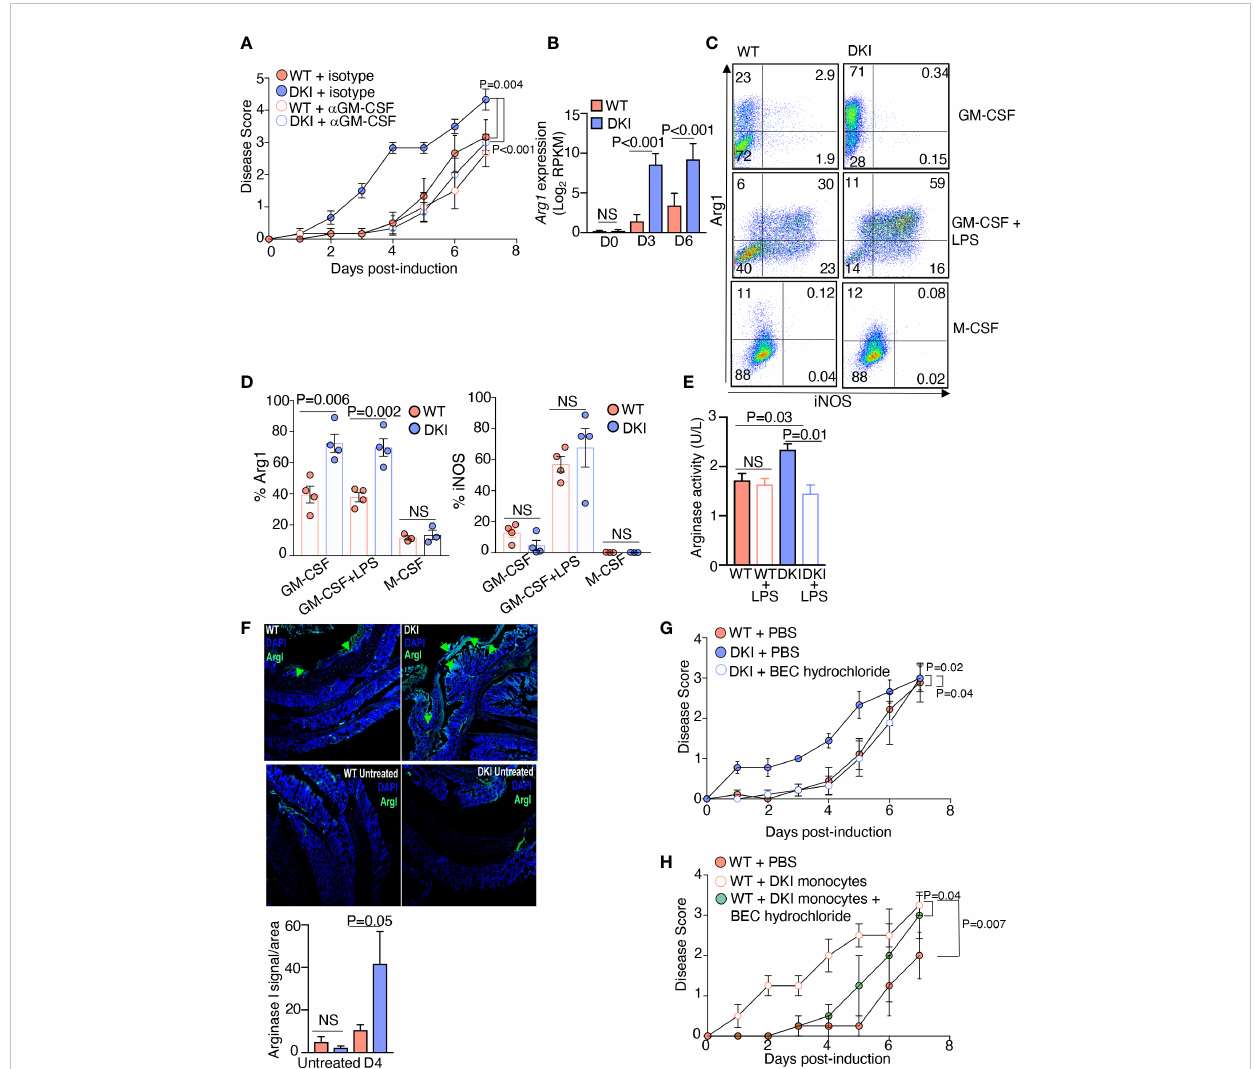
FIGURE 5 Arginase I Production by DKI Monocytes Promotes Colitis Severity. (A) Anti-GM-CSF or an isotype control antibody were administered to WT and DKI mice on days 0, 2, and 4 following 1% DSS administration. Mice were treated with DSS for 7 days. Disease scores are shown. Data are from 3 independent experiments with n=6. (B) Gene expression level of Arg1 in WT and DKI MDCs following 0, 3, and 6 d of differentiation with GM-CSF. Data are combined from 3 independent experiments. (C,D) Expression of iNOS and arginase I in WT and DKI MDCs following 8 d of differentiation with either GM-CSF or M-CSF. Some MDCs were differentiated with GM-CSF, then stimulated with LPS for 16 h. Representative dot plots (C) and the combined results (D) from 4 independent experiments are shown. (E) Arginase I activity in WT and DKI MDCs differentiated with GM-CSF for 8 d. Some MDCs were stimulated with LPS for 16h. Activity was measured for 20 min. Data are combined from 3 independent experiments. Shown is the activity of arginase in unit per liter (U/L), de fi ned by the amount of arginase that generates 1 m mol of H 2 O 2 per minute at pH 8 at 37 ° C. (F) Representative images showing the expression of arginase I in WT and DKI colons with or without 4 d of DSS treatment. Data are from 2 independent experiments with n=6. (G) Disease scores from WT mice, DKI mice, and DKI mice treated with BEC hydrochloride 0, 1, and 2 d following colitis induction. Data is combined from